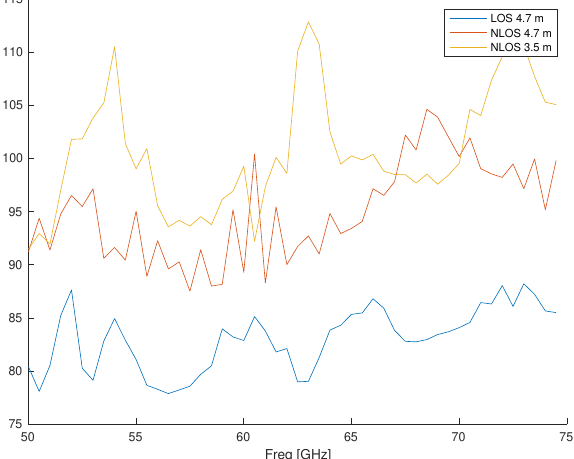
Figure 6. Measured path loss as a function of frequency for angle of arrival (AoA) with minimum PL at 60